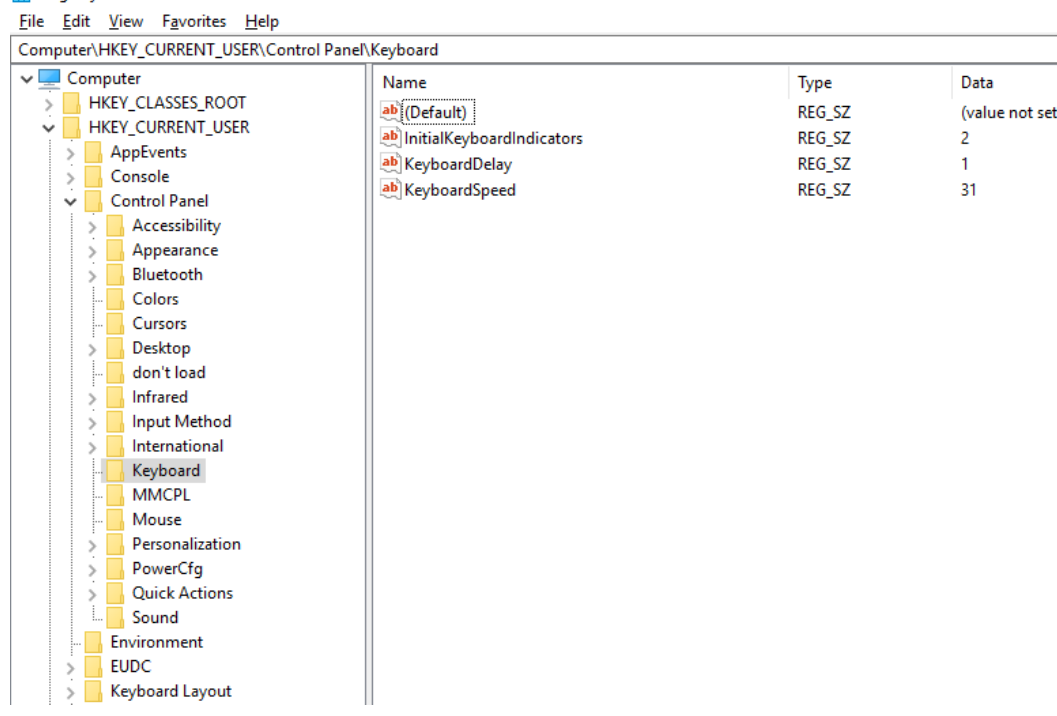
Figure 1. The structure of the Windows